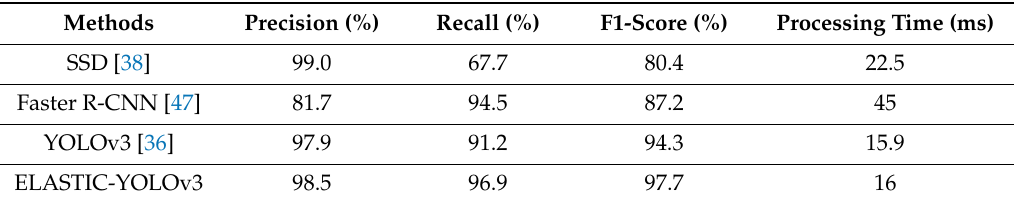
Table 3. Comparison of the precision, recall, F1-score, and processing time of four methods using NightFire-DB. SSD, single-shot